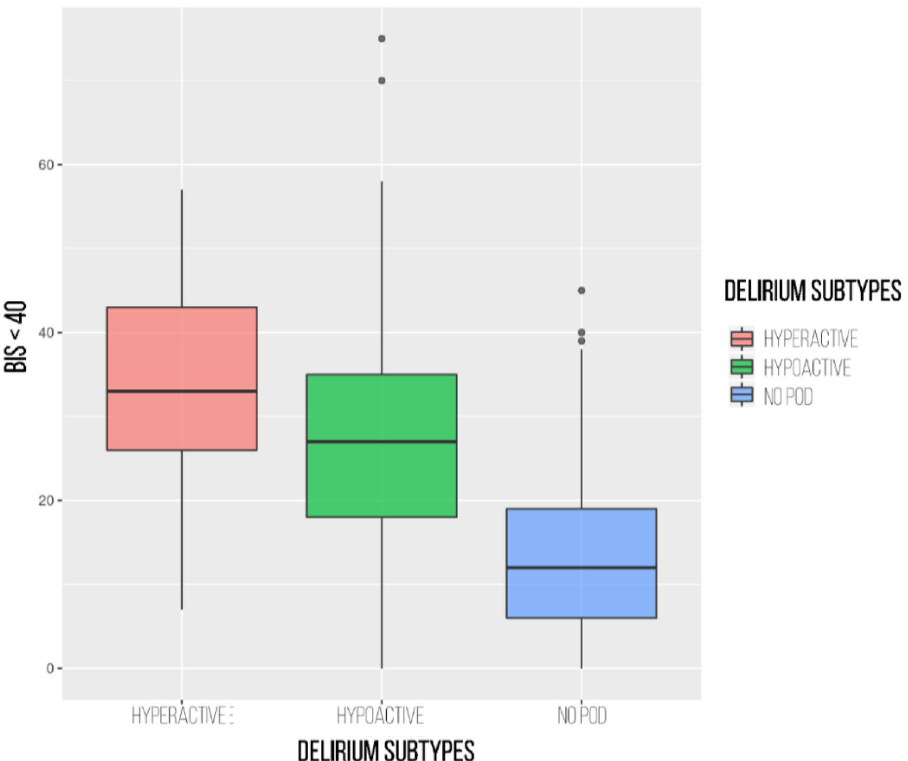
Figure 2. Incidence of postoperative delirium and its relationship with the minutes of anaesthesia depth. BIS < 40 indicates the time in minutes that the BIS value has been below